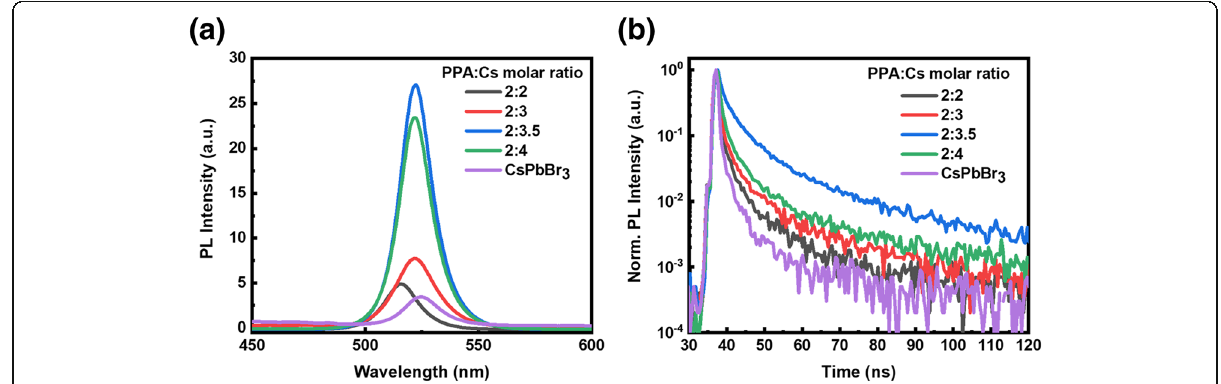
Fig. 4 a PL spectra and b normalized TRPL decay curves of perovskite films with different molar ratios of